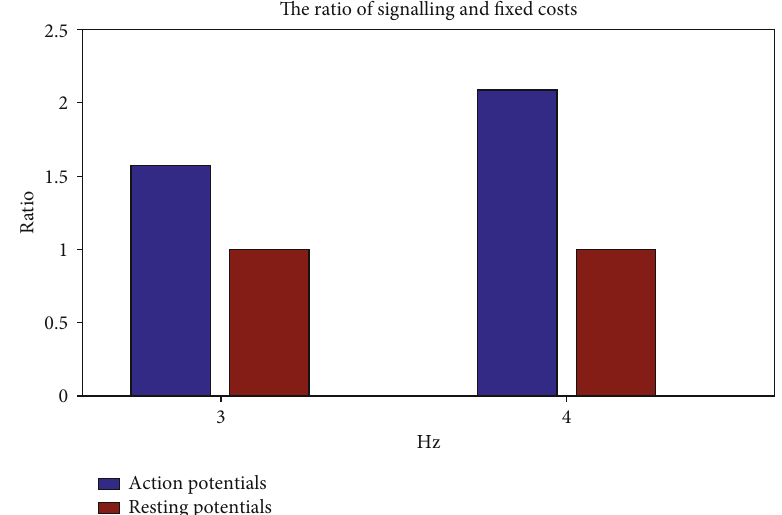
Figure 5: The ratio of signaling cost to fi xed energy cost.